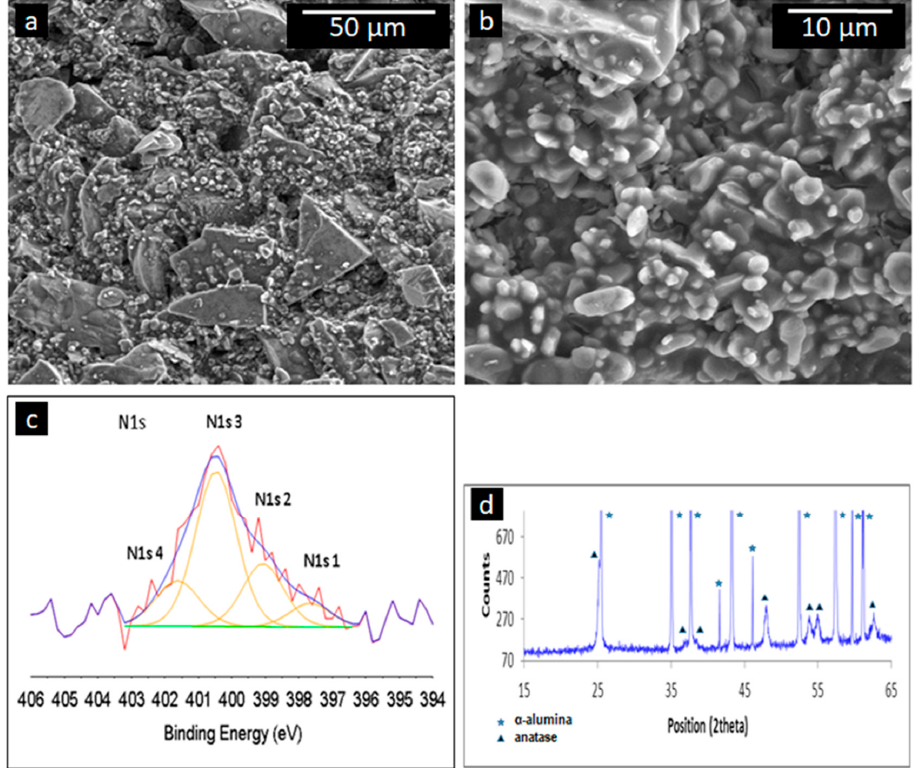
Figure 7. Material characterization results of the N-doped TiO 2 coated membrane: ( a , b ) scanning electron microscopy (SEM) images; ( c ) a peak fitted XPS N 1s spectrum; ( d ) glancing-angle X-ray